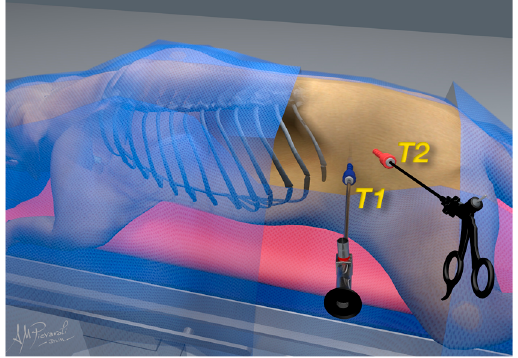
Figure 1. Positions of T1 and T2 are represented in the figure. T1 is behind the last rib and T2 is in the paralumbar fossae.